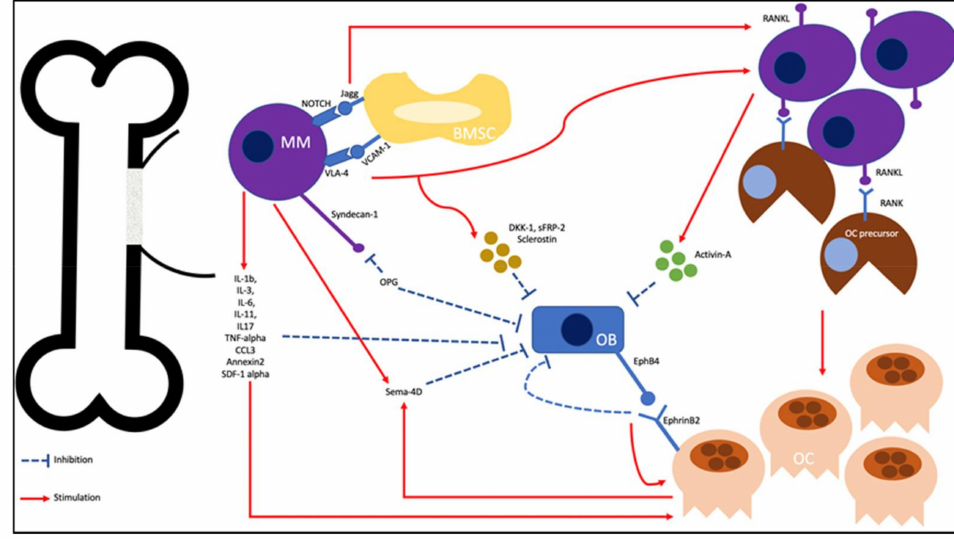
Figure 1. Pathogenesis of multiple myeloma (MM) -related skeletal-related events